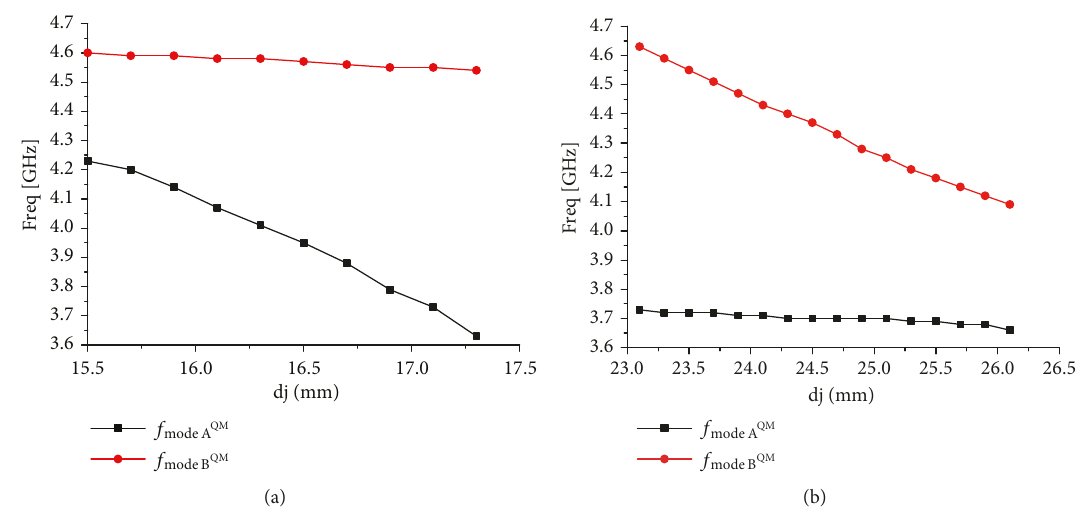
Figure 8: Resonant frequency of QMSIW with different